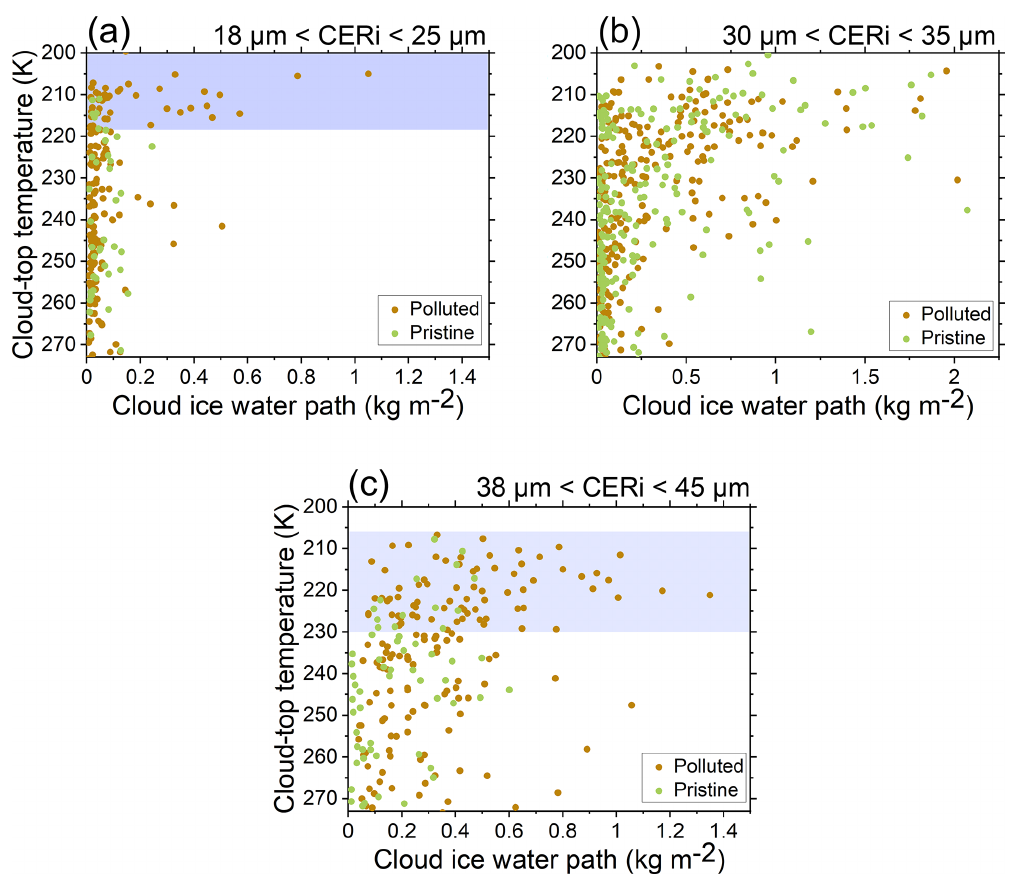
Figure 12. Scatterplots between CIWP and CTT of HU under different conditions of CER i , with (a) 18µm < CER i < 25µm, (b) 30µm < CER i < 35µm, and (c) 38µm < CER i <